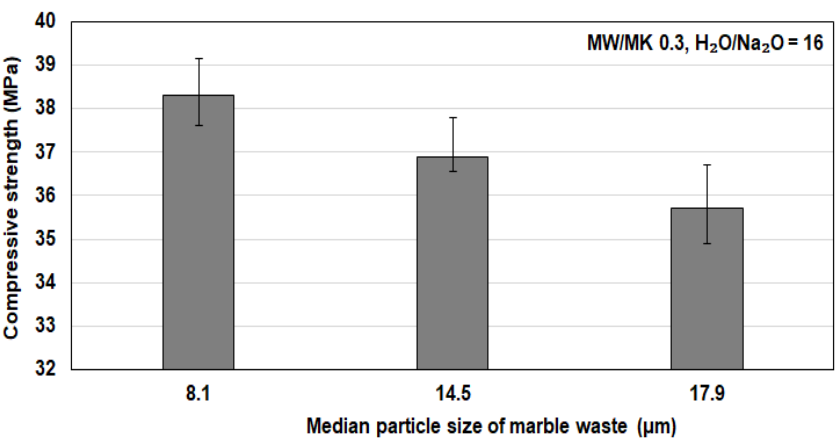
Figure 3. Effect of marble waste median particle size on the 7-day compressive strength of AAMs produced using marble waste to metakaolin mass ratio 0.3, curing temperature 40 °C and H 2 O/Na 2 O ratio in the activating solution 16 (the d 90 of metakaolin used was quite similar to the respective value of marble waste, 25.5 µm).